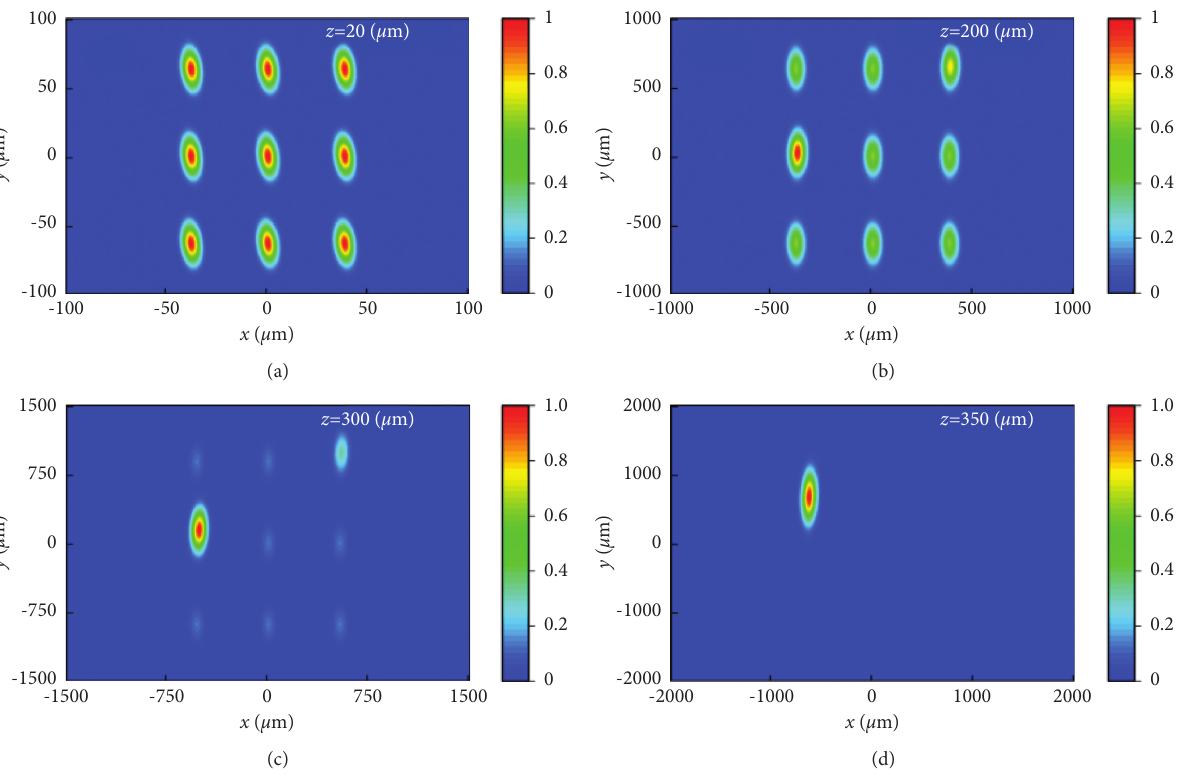
Figure 2: Mergence of the spectral intensity at several propagation distances in turbulent biological tissue while biological tissue medium parameters are chosen, D f � 2.60, l c �